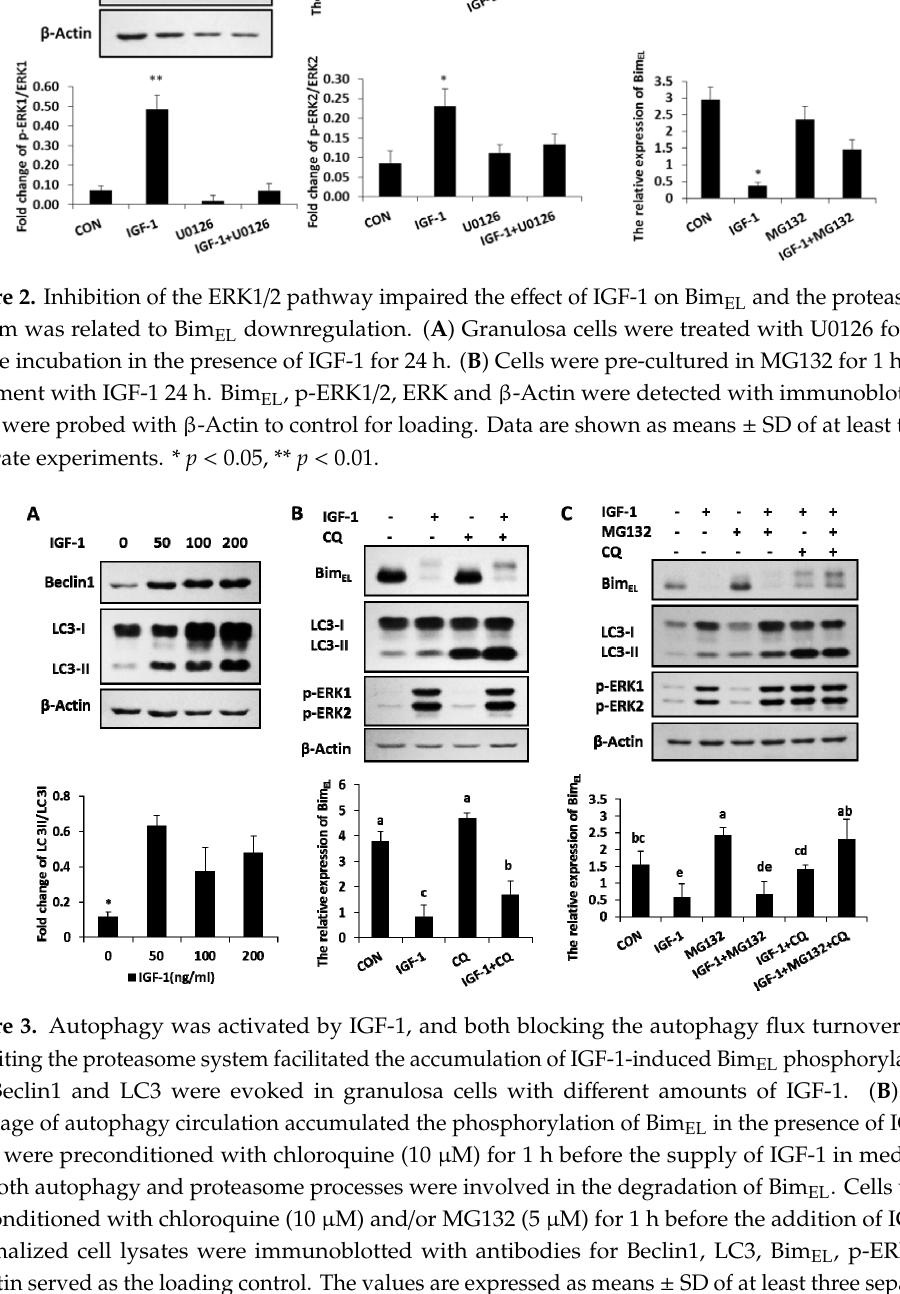
Cells were preconditioned with chloroquine (10 µ M) for 1 h before the supply of IGF-1 in medium. ( C ) Both autophagy and proteasome processes were involved in the degradation of Bim EL . Cells were preconditioned with chloroquine (10 µ M) and / or MG132 (5 µ M) for 1 h before the addition of IGF-1. Normalized cell lysates were immunoblotted with antibodies for Beclin1, LC3, Bim EL , p-ERK1 / 2. β -Actin served as the loading control. The values are expressed as means ± SD of at least three separate experiments. * p < 0.05. a, b, c, d, e, di ff erent letters represent significant di ff erence ( p < 0.05) statistically, and same letters represent no change